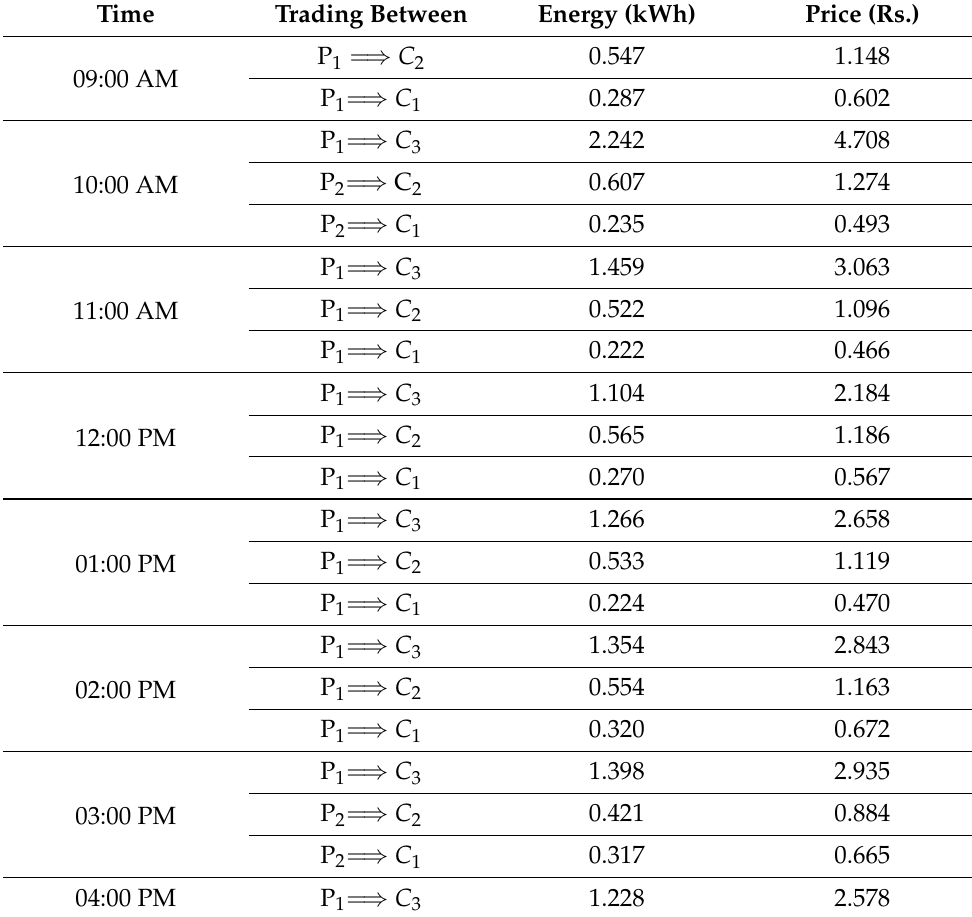
Table 5. Energy sharing